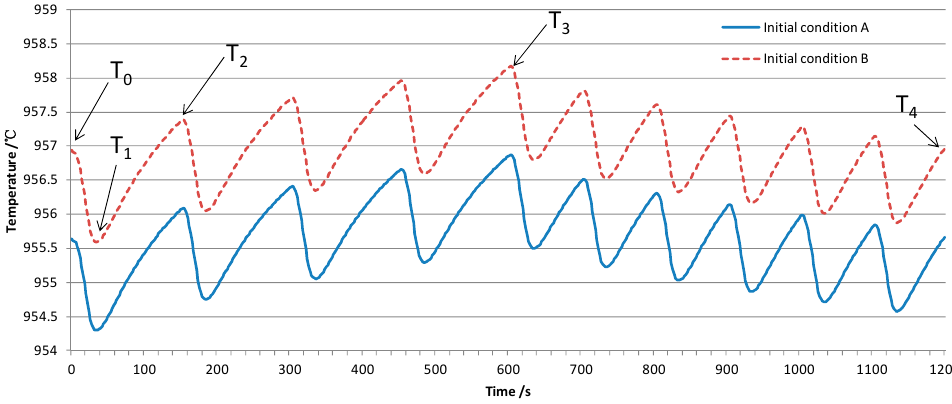
Figure 3. Sensitivity of the simulated curve.